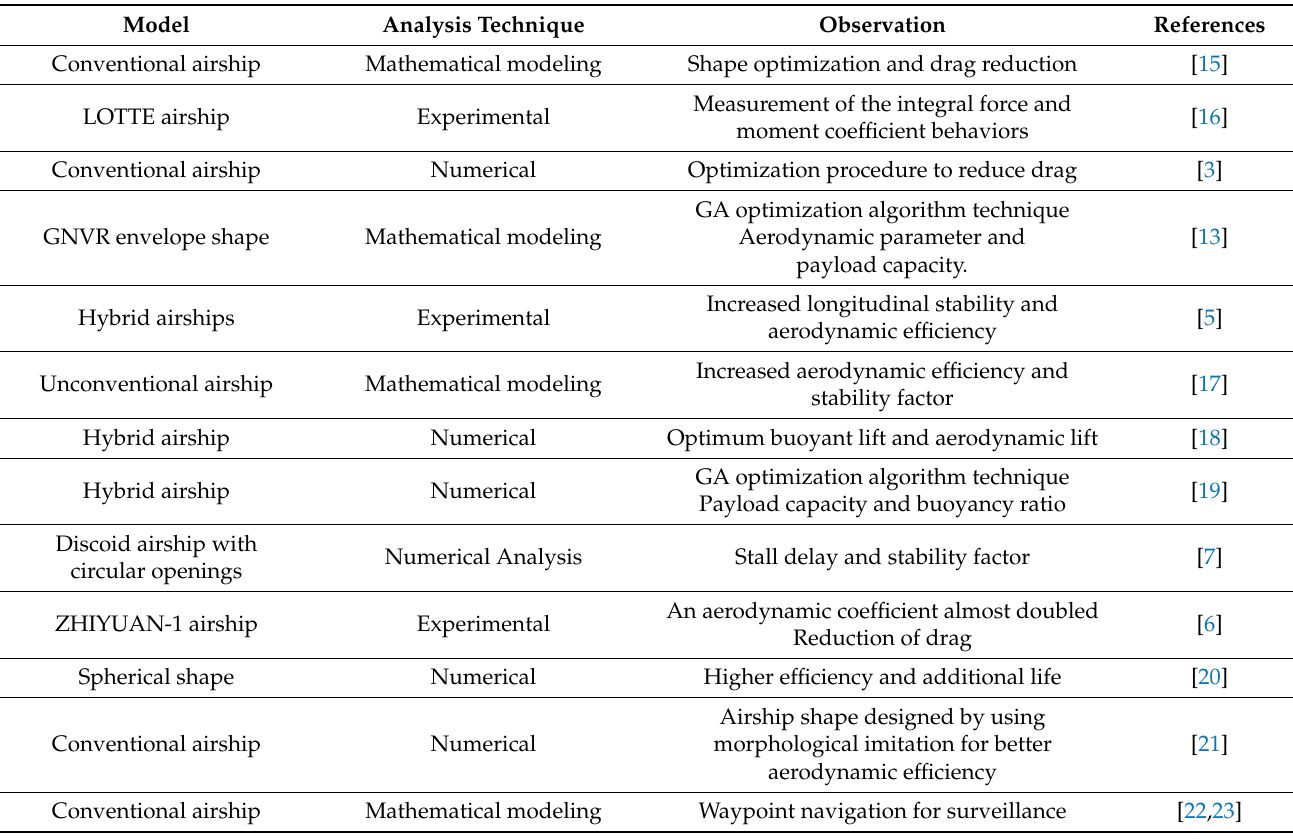
Table 1. Previous research on hybrid